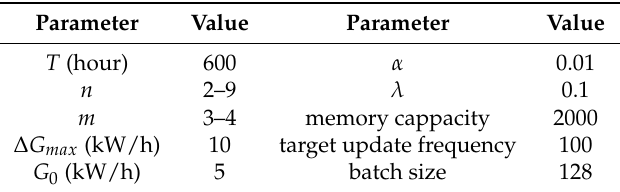
Table 1. Experimental parameter